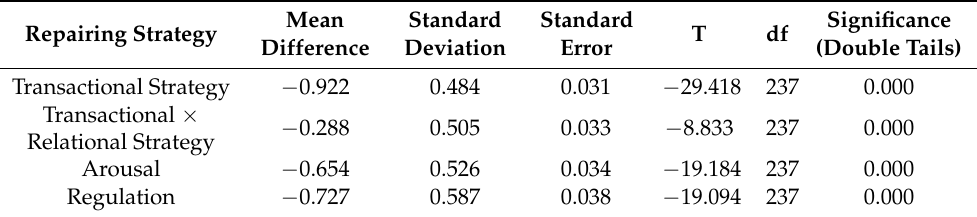
Table 5. Results of the pairwise t